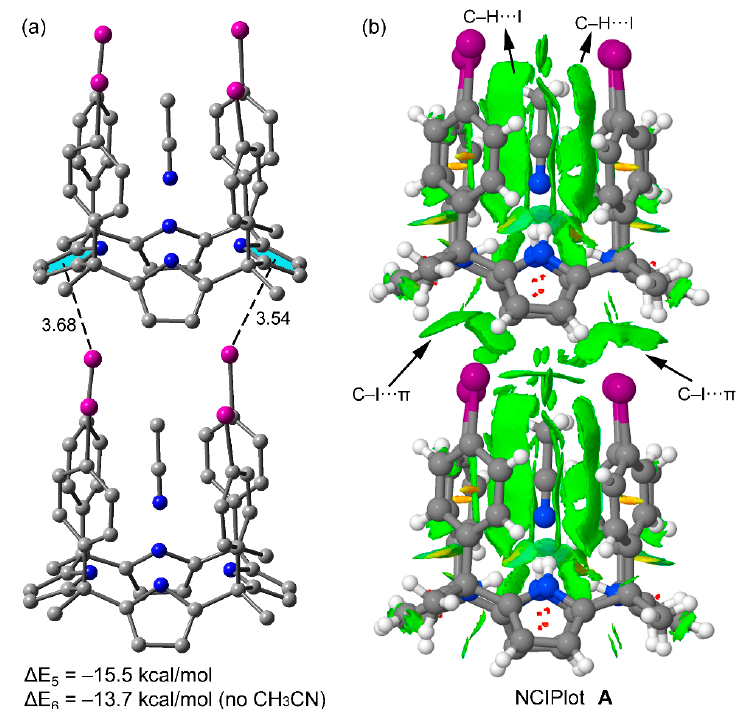
Figure 8. ( a ) Supramolecular dimer retrieved from the X-ray structure of polymorph A . Distances in Å ( b ) NCIPLOT of the dimer retrieved from the X-ray structure of polymorph A . The gradient cut-off is s = 0.35 au, and the color scale is − 0.04 < ρ < 0.04 au.